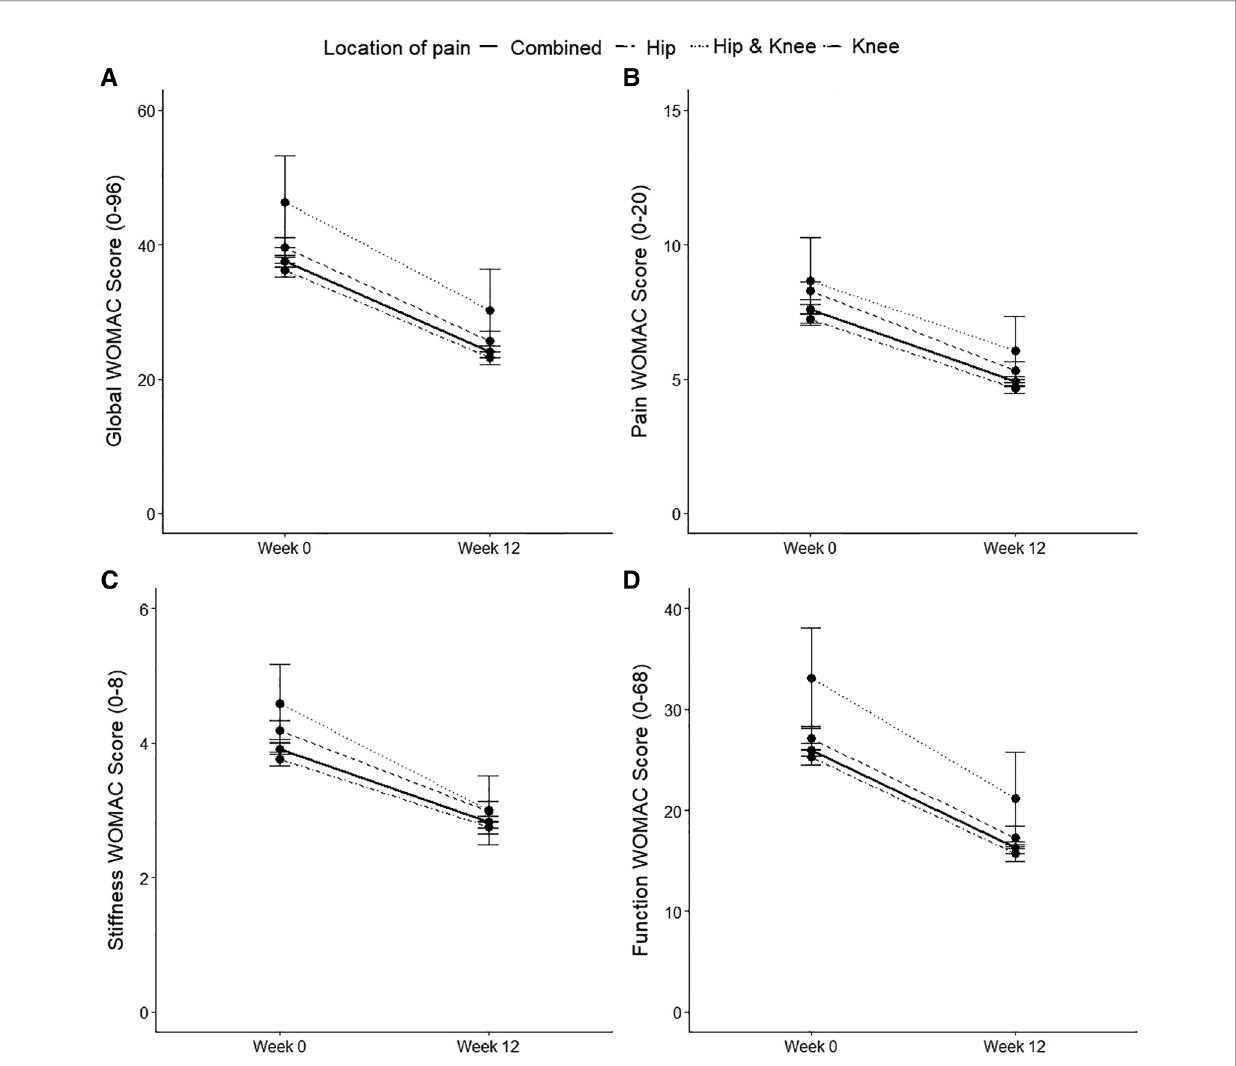
FIGURE 1 Baseline and Week 12 values for global WOMAC scores ( A ); pain score ( B ); stiffness score ( C ); and function score ( D ). Values are presented as mean (95% CI). Higher scores indicate worse symptoms for WOMAC scores. Differences between time points were analysed using paired t -tests. For all groups, all p <0.001. All patients Combined: n =1593; Hip only: n =505; Knee only: n =1,055; Hip & Knee: n